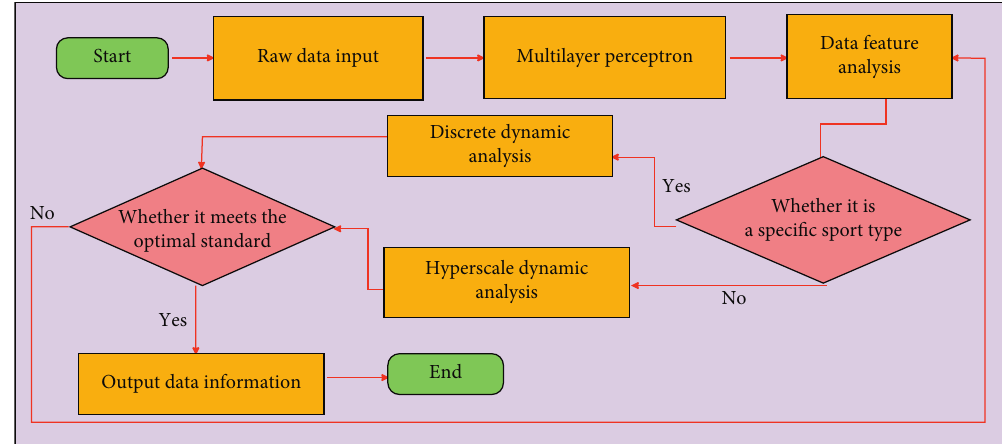
Figure 1: Data analysis process of sports data mining model based on discrete dynamic modeling technology.